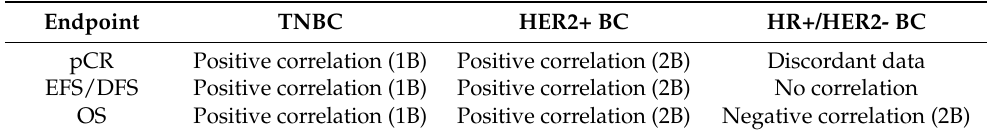
Table 1. TILs prognostic value with level of evidence across BC subtypes (early setting).